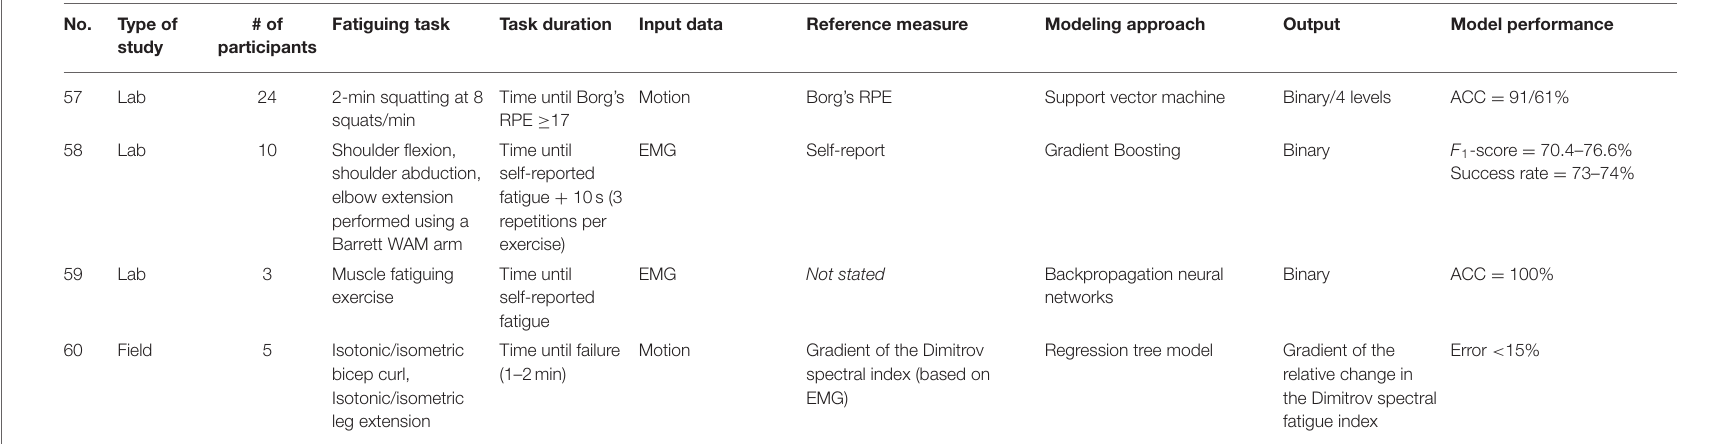
TABLE 7 | Summary of characteristic of studies that investigated muscle fatigue quantification using wearable devices. No.